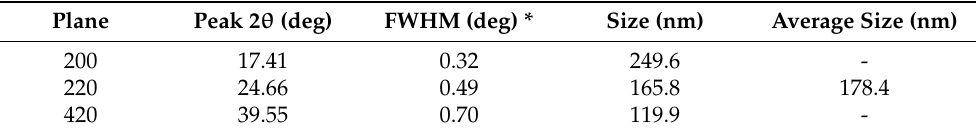
Table 2. Particle size of CoHCF thin film estimated from peaks of XRD patterns.